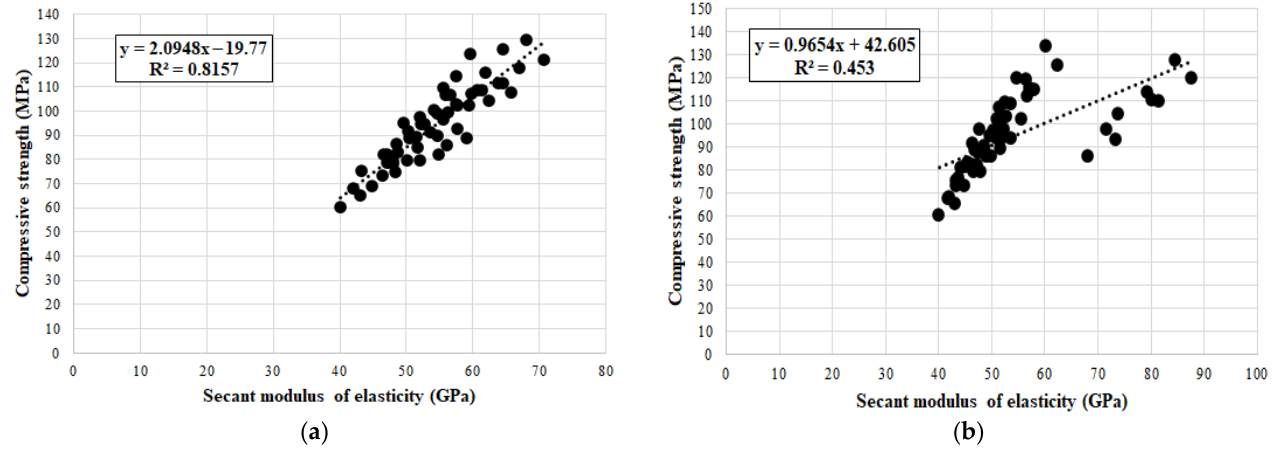
Figure 17. Effect of the fibres on the secant modulus of elasticity of HSC ( a ) SF and ( b ) PPF.